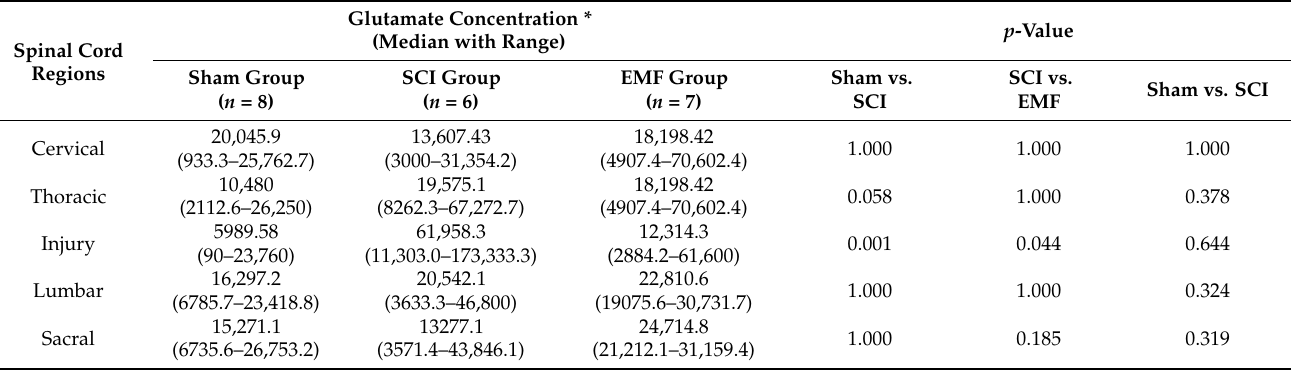
Table 1. Effect of electromagnetic stimulation on glutamate after 8-week complete SCI.